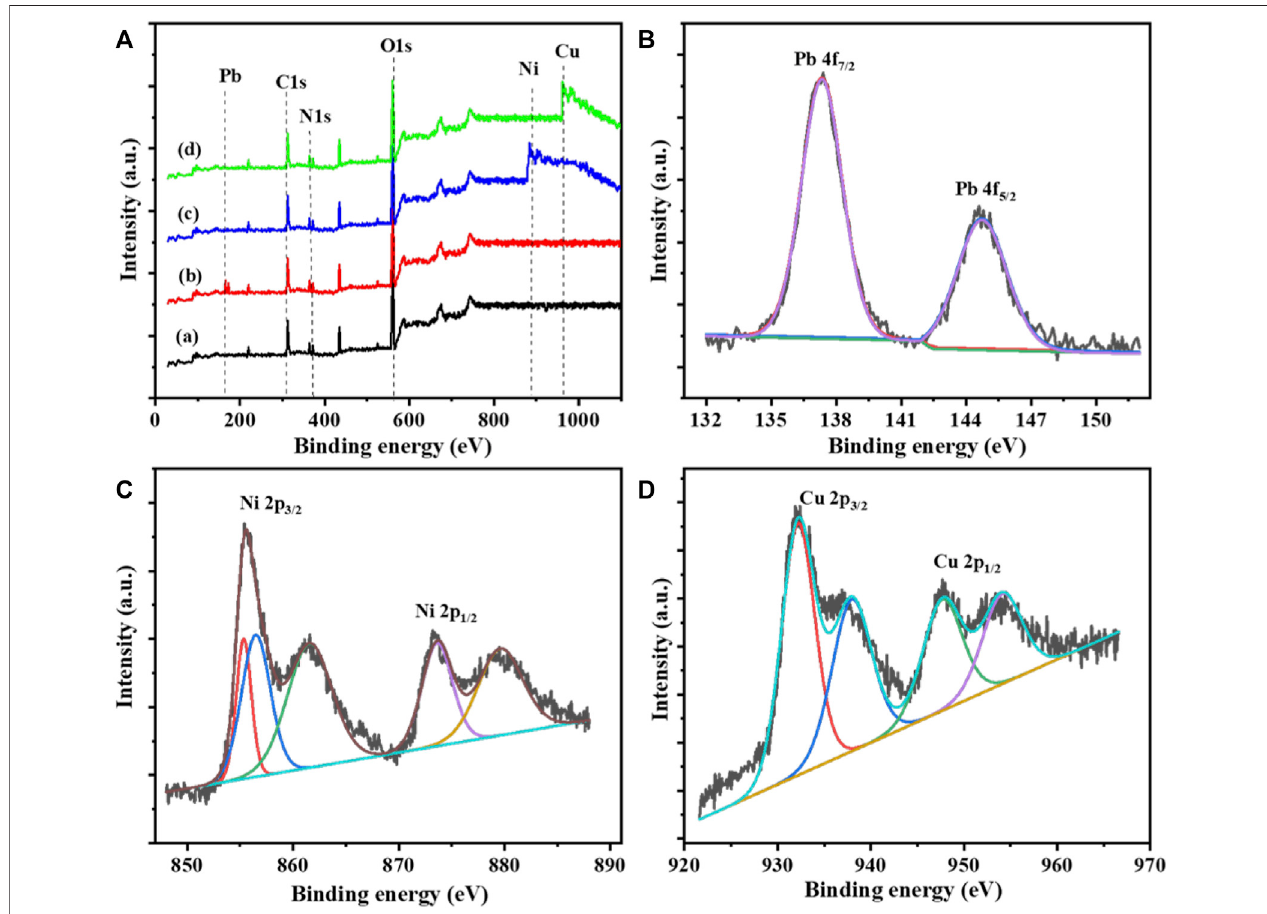
FIGURE 4 | Effect of mesh size on percentage removal of Cu 2+ , Ni 2+ , and Pb 2+ using the PANI-WH composite.